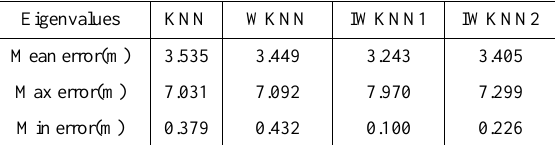
Table 2 . Positioning results when using MEIZU smartphone.